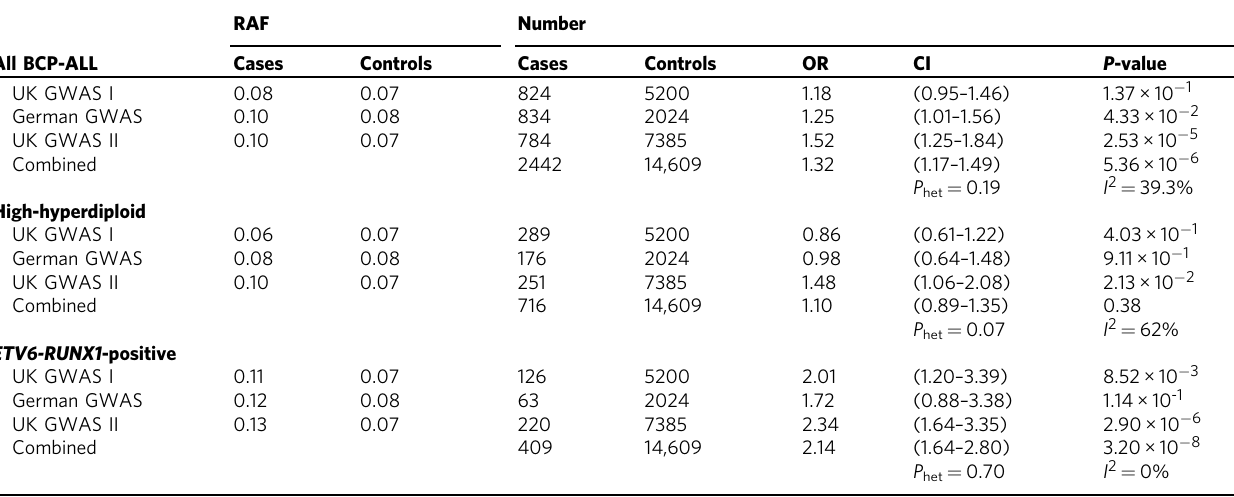
Table 2 rs17481869 (2q22.3) genotypes and risk associated with BCP-ALL, high-hyperdiploid, and ETV6-RUNX1 childhood BCP-ALL